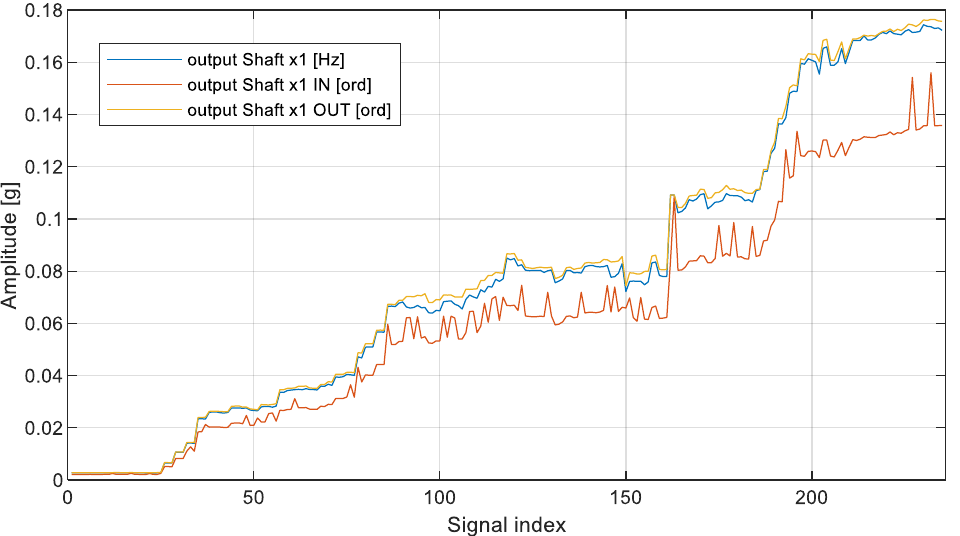
Figure 10. Narrowband output_shaft_x1 HIs in detection of imbalance state. Abscissa is the same as in Figure 9.